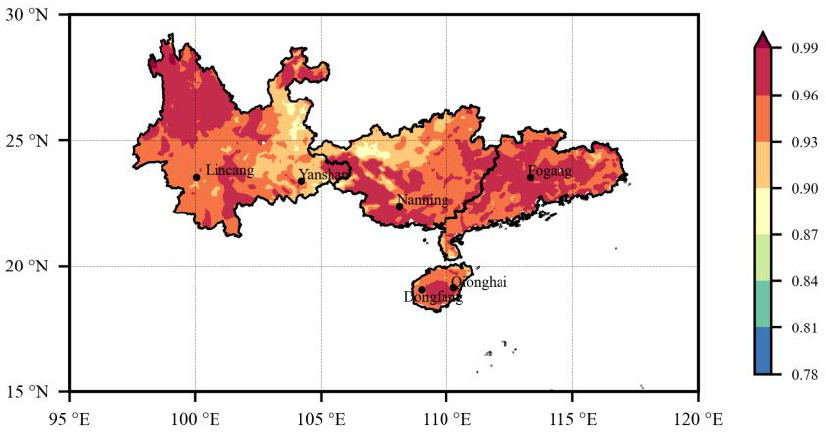
Figure 6. The distribution of Pearson correlation coefficient between the surface and subsurface weekly SWDI during 2017–2019.